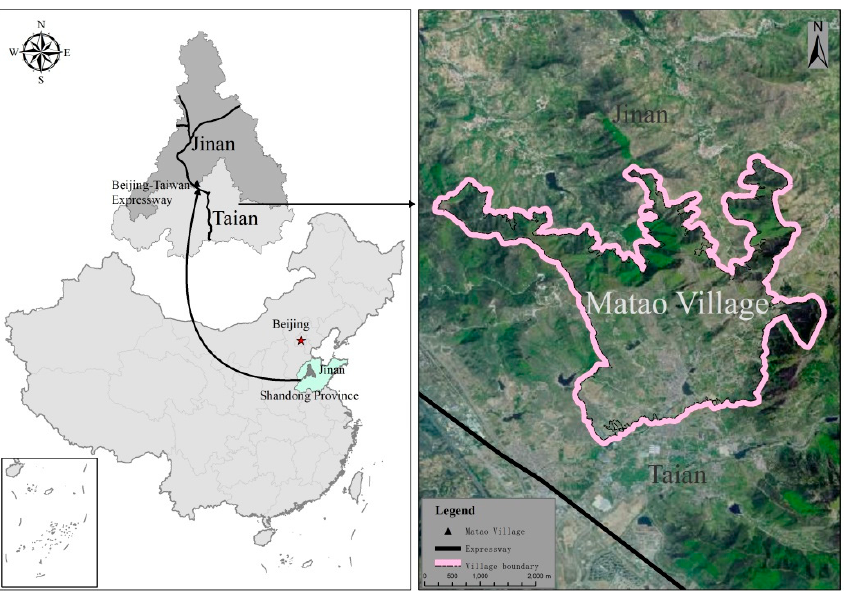
Figure 1. Geographical location of Matao Village.